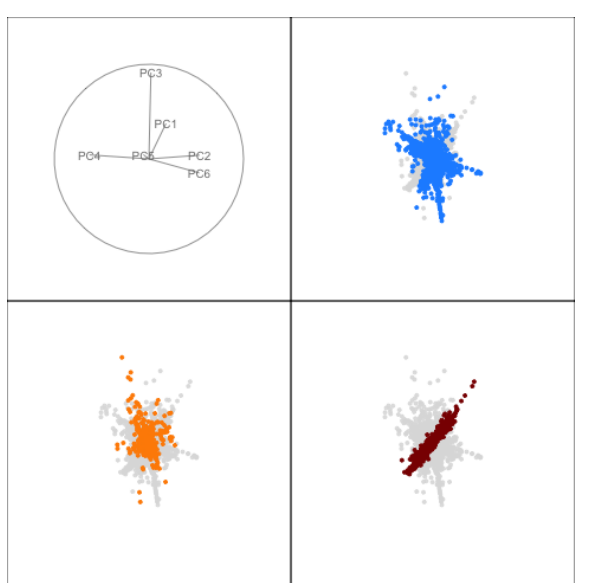
Figure 2. Example projection of the full dataset viewed with the tour, see here for full animation. The points are grouped into DIS (blue), VBP (orange) and jets (red) type measurements and the example illustrates the orthogonality between these